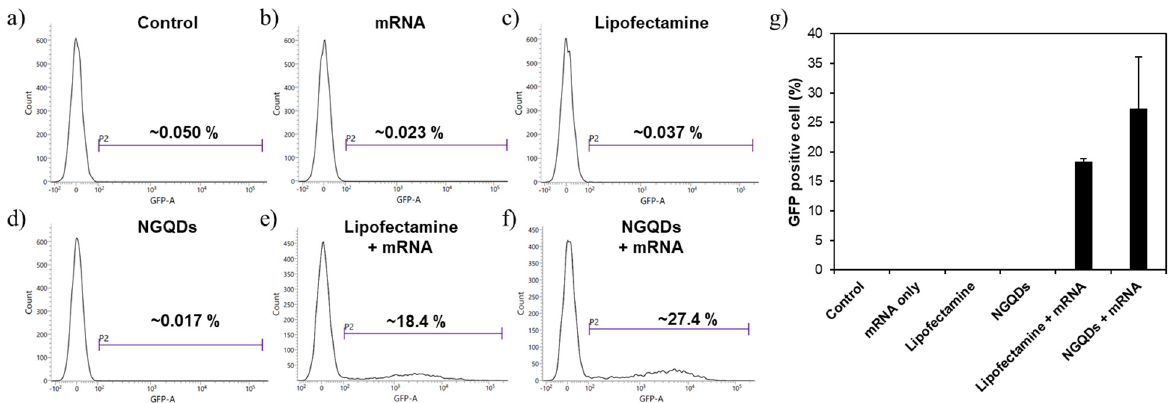
Figure 6. Flow cytometry analysis of HeLa cells after 24 h transfection with each group; ( a ) control, ( b ) mRNA only, ( c ) Lipofectamine only, ( d ) NGQDs only, ( e ) Lipofectamine + mRNA complex, ( f ) NGQDs + mRNA complex groups. ( g ) mRNA transfection efficiency of each group.